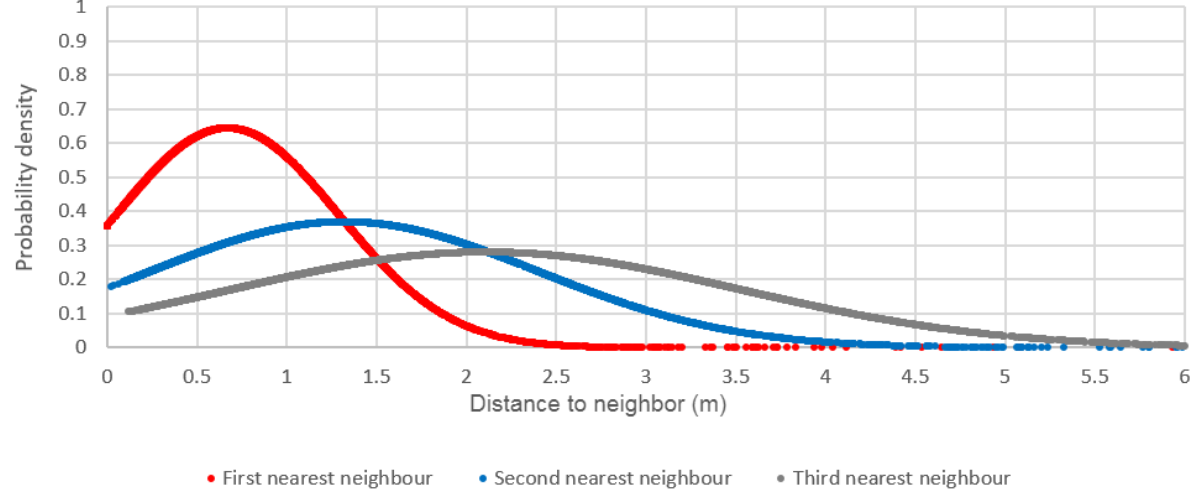
Figure 4. Normalized distribution of the distance between dwellings and their first, second, and third nearest neighbors in Klipfontein Glebe.